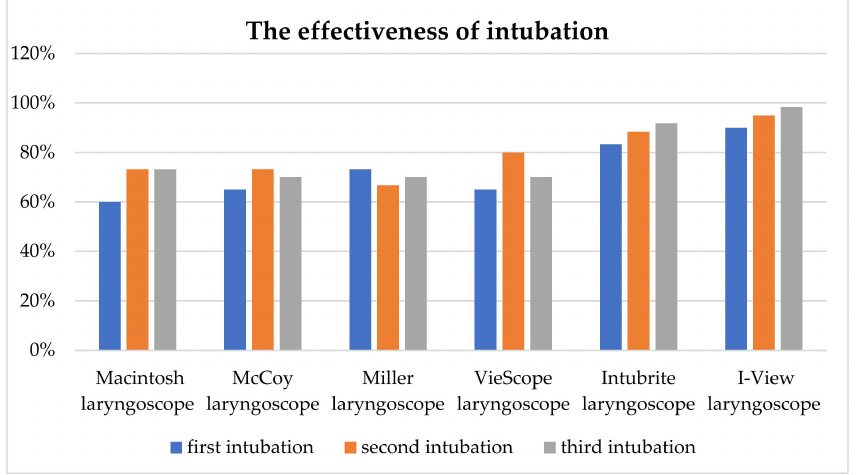
Figure 2. Graph of the percentage success of intubation with a given laryngoscope in subsequent attempts.